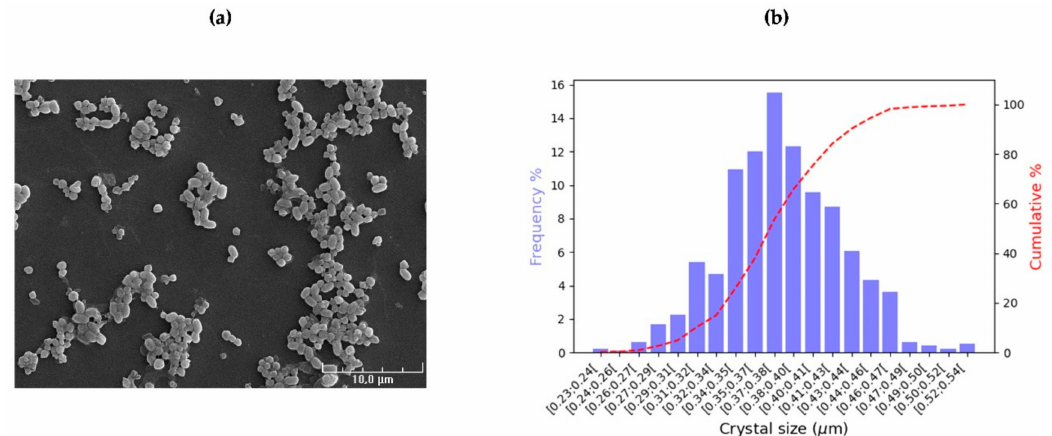
Figure 6. ( a ) SEM image of the AR23 purified crystals. ( b ) Graph representing the radius size distribution in terms of frequency and cumulative percentage for the spherical crystals.